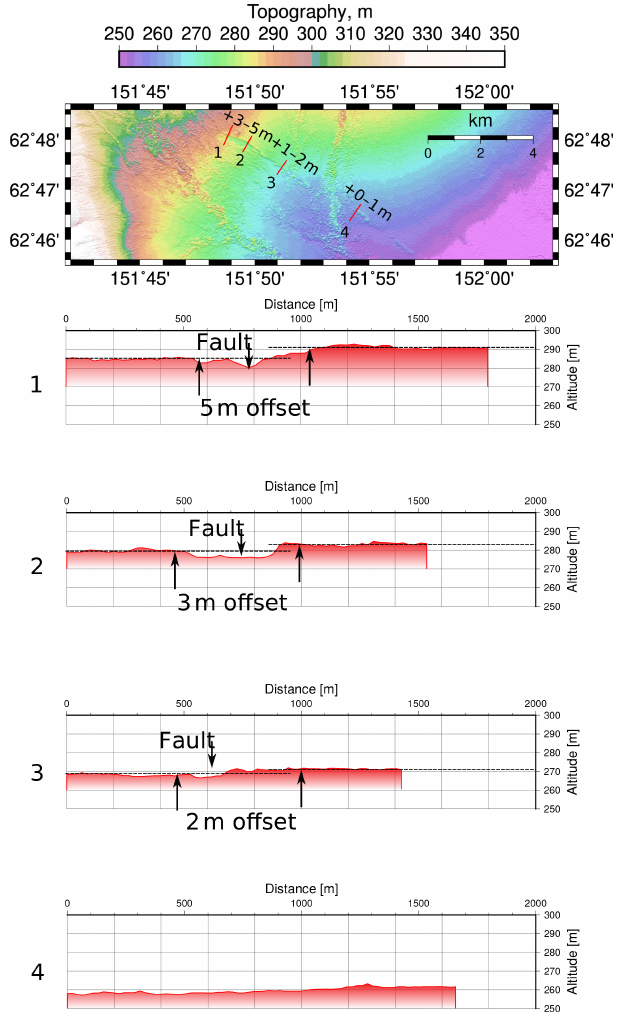
Figure 9. Topographic profiles, showing vertical offsets across pre- sumed scarp at the western end of the Seymchan Basin, assumed to mark the termination of the 90km Ulakhan fault segment. Off- sets reach a similar maximum value to the scarp on the Buyunda fan and diminish rapidly to the west, but more gradually, over a dis- tance of ∼ 5km, to the east. Sense of offset is reversed relative to the Buyunda scarp (Fig. 7).